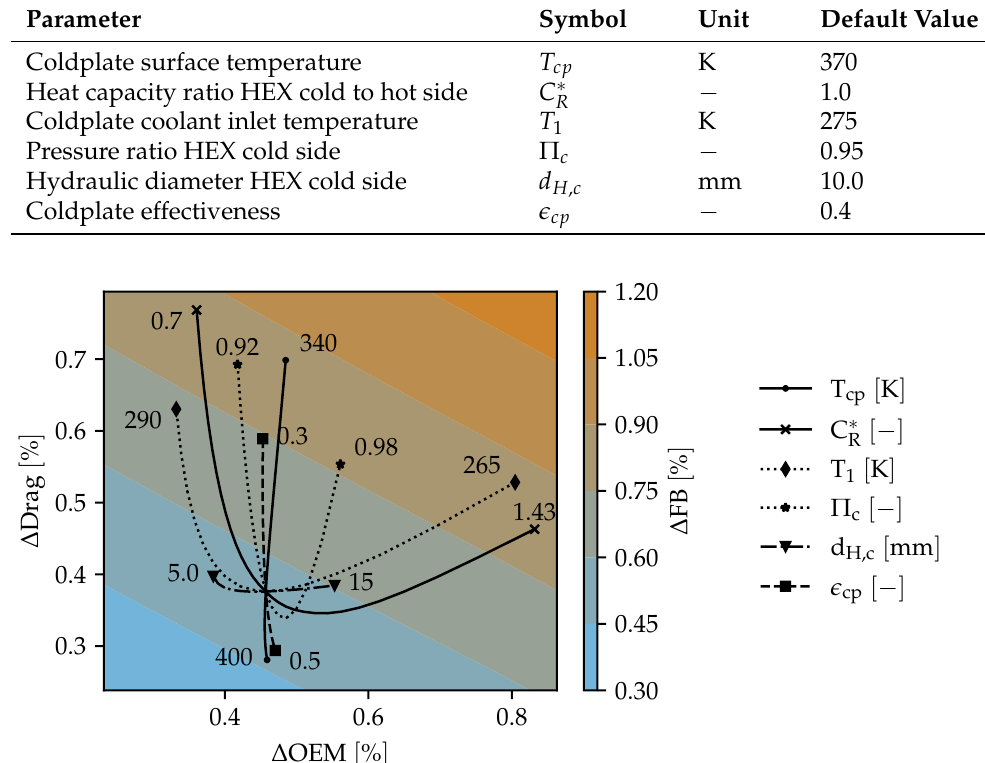
Figure 7. One-dimensional sensitivity